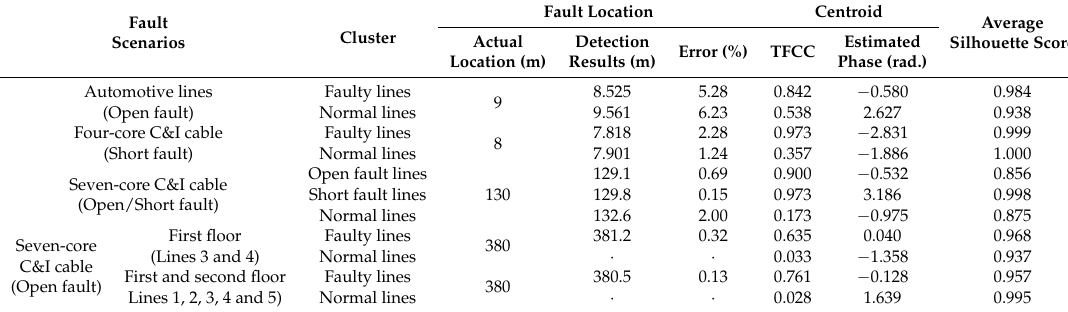
Table 1. Fault location and clustering